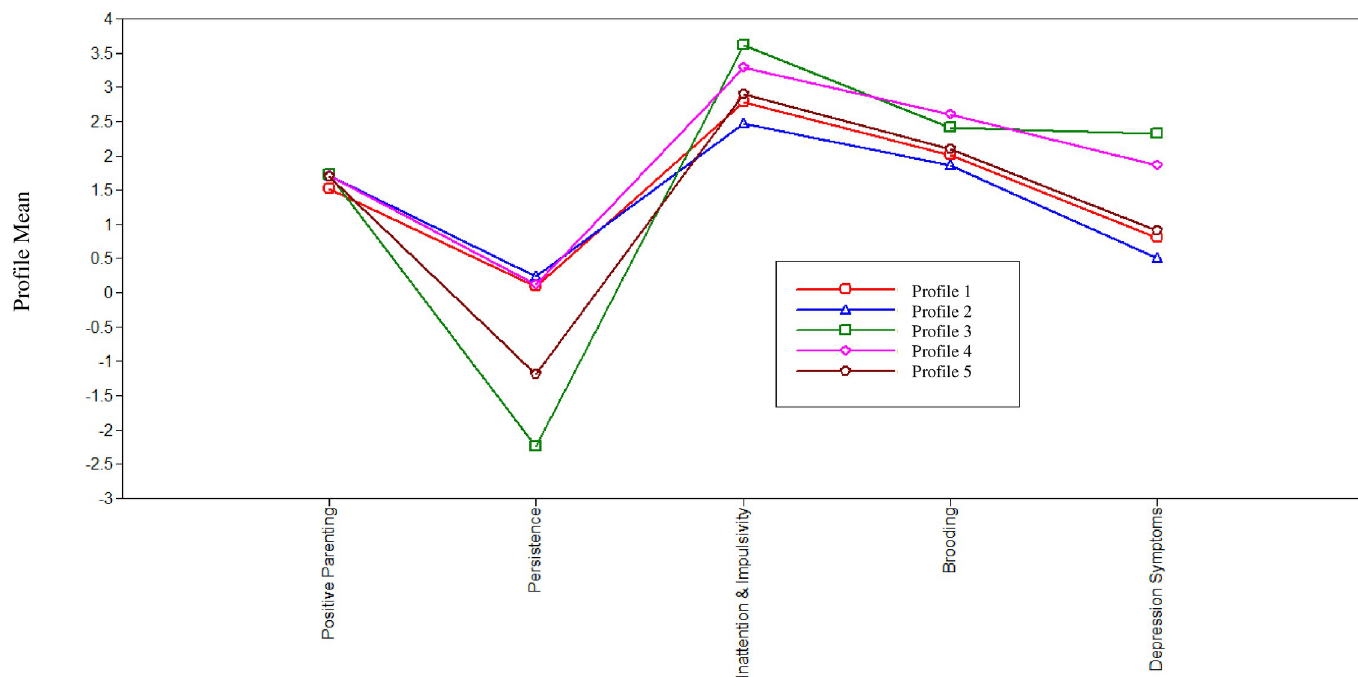
Fig 1. Illustration of the 5-profile